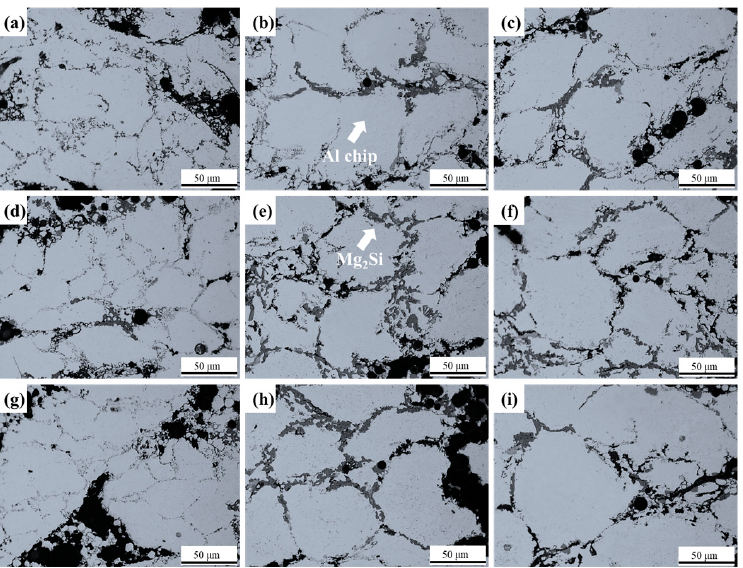
Figure 7. 500x magni fi cation OM images of microstructures of each sample; ( a ) Al50G5, ( b ) Al60G5, ( c ) Al70G5, ( d ) Al50G10, ( e ) Al60G10, ( f ) Al70G10, ( g ) Al50G15, ( h ) Al60G15, ( i ) Al70G15.